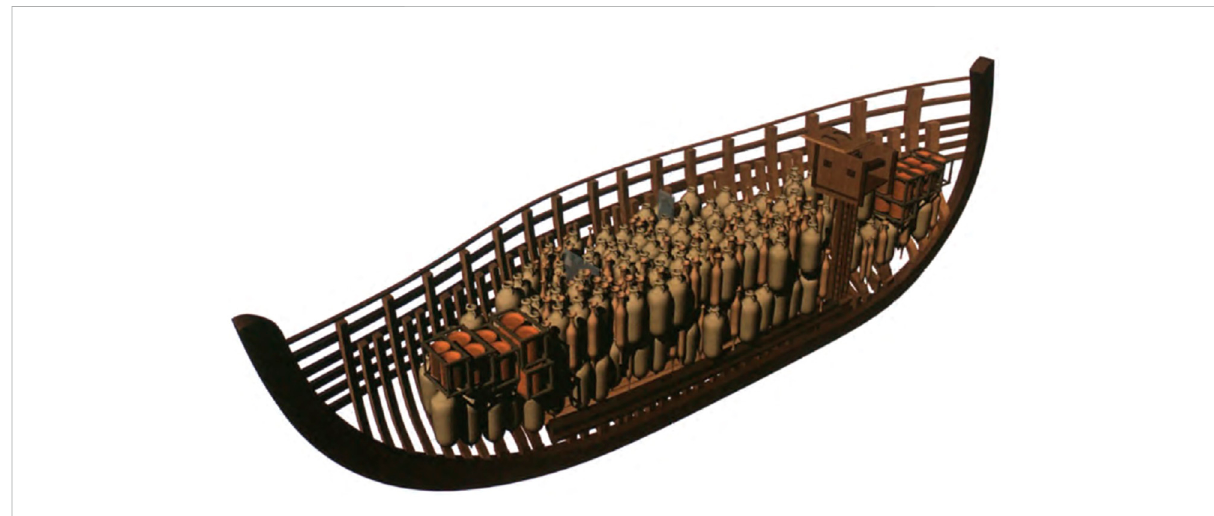
FIGURE 4 Reconstruction of the Dramont E wreck, a comparable late roman merchant ship of the same period as the Veliki Piruzi wreck, also carrying a mixed cargo from North Africa (Fiederling, 2019)